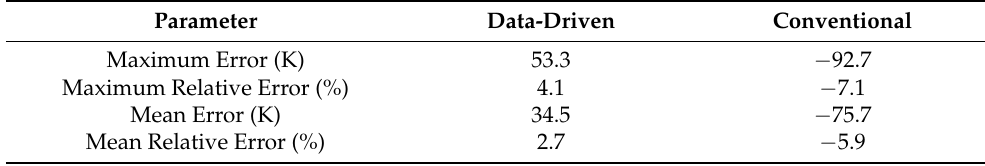
Table 4. Calculation error of the middle section temperature.